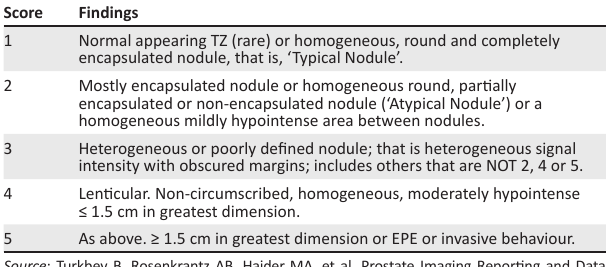
TABLE 5: Characterisation and scoring of a lesion in the TZ. Findings